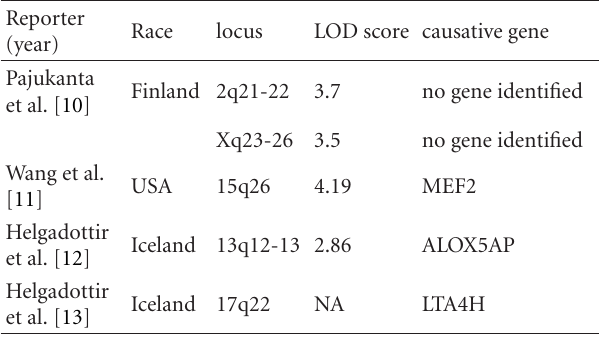
Table 2: Representative loci associated with CAD identified in the family-based